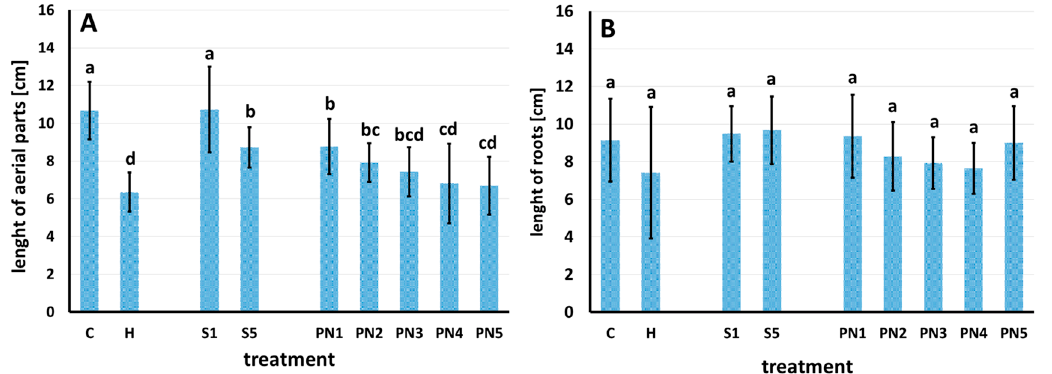
Figure 8. Length of aerial parts ( A ) and length of roots ( B ) of barnyard grass seven days after spraying with water—C, herbicide—H, surfactants—S1 (1% v / v ) and S5 (10% v / v ), and nanoemulsions with peppermint oil PN1 (1% v / v ), PN2 (1.5% v / v ), PN3 (2% v / v ), PN4 (5% v / v ), and PN5 (10% v / v ). Bars represent mean value ± SD. The letters a–d indicate statistically significant differences. Values indicated by the same letters did not differ significantly at p ≤ 0.05 according to Duncan’s test (within the tested species), n = 4.